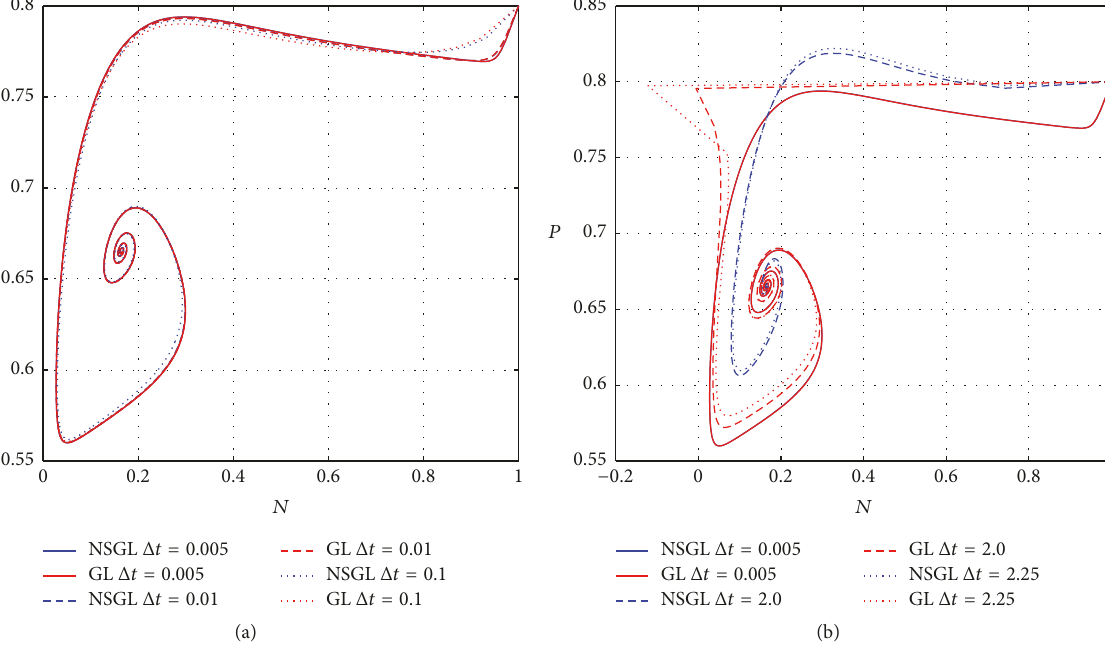
solutions which are initially distorted from solutions